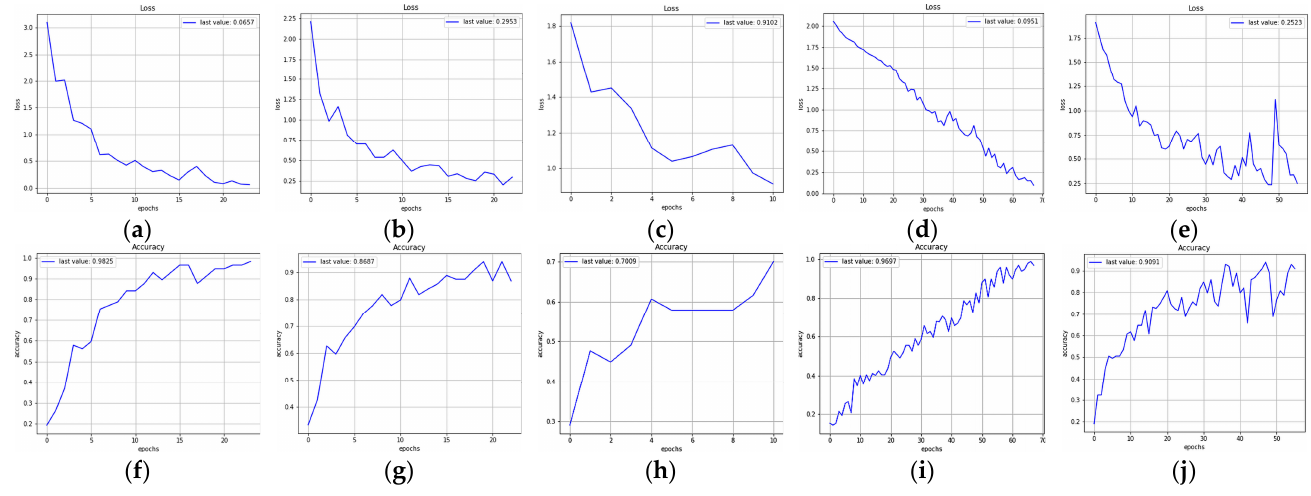
Figure 14. Loss and accuracy of 128 × 128 sub-images processed by ( a , f ) FlexibleNet, ( b , g ) ResNet50, ( c , h ) EfficientNetB5, ( d , i ) MobileNetV3-Large, and ( e , j ) Xception.